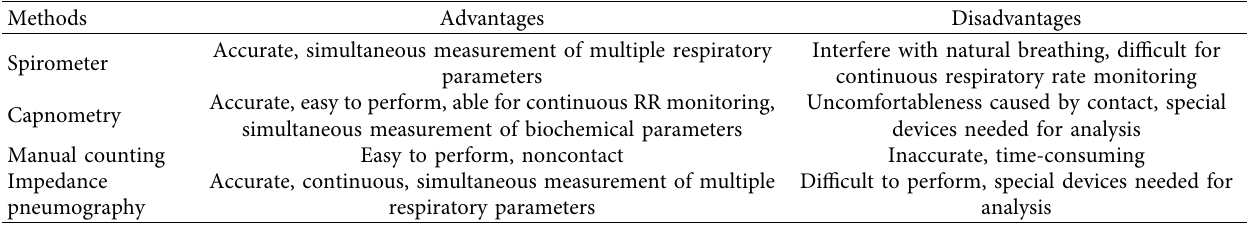
Table 1: Current mainstream methods used for clinical respiratory rate